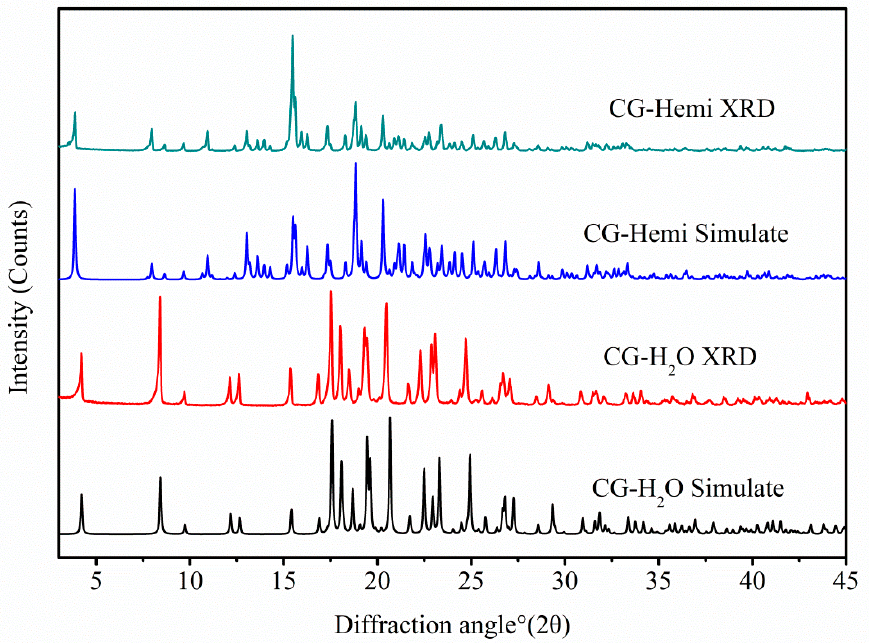
Figure 8. Experimental PXRD patterns and simulated PXRD patterns from the crystal structure of CG-Hemi and CG-H 2 O.